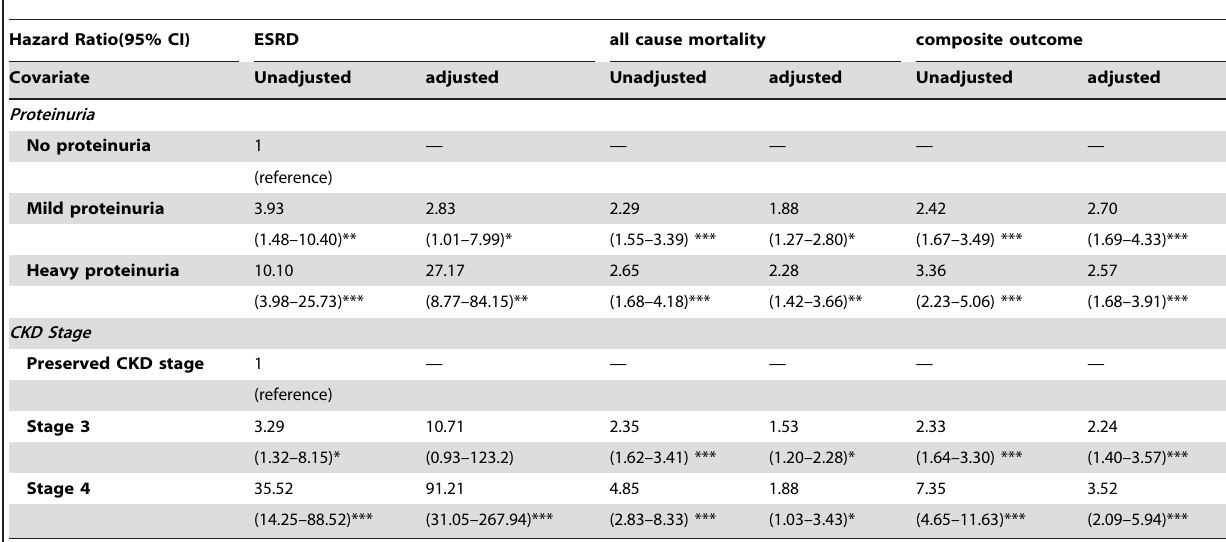
Table 4. Factors associated with long- term adverse outcomes (N =925).